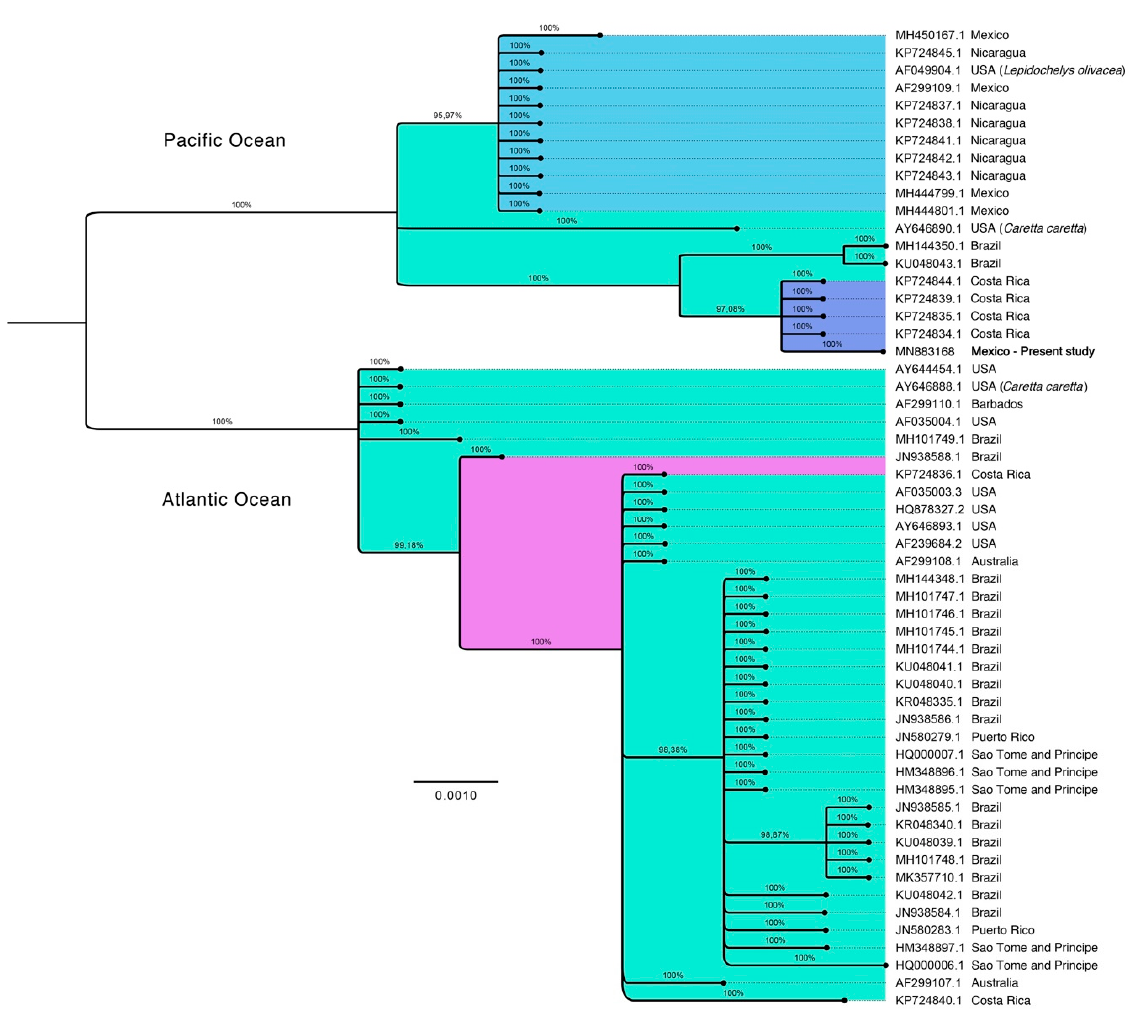
Figure 3. Bayesian phylogenetic tree. UL30 concatenated long sequence of the black turtle ( Chelonia mydas ) from Ojo de Liebre Lagoon and previously reported sequences retrieved from the GenBank. Probabilities are shown for node support. Scale bar indicates nucleotide substitutions per site.